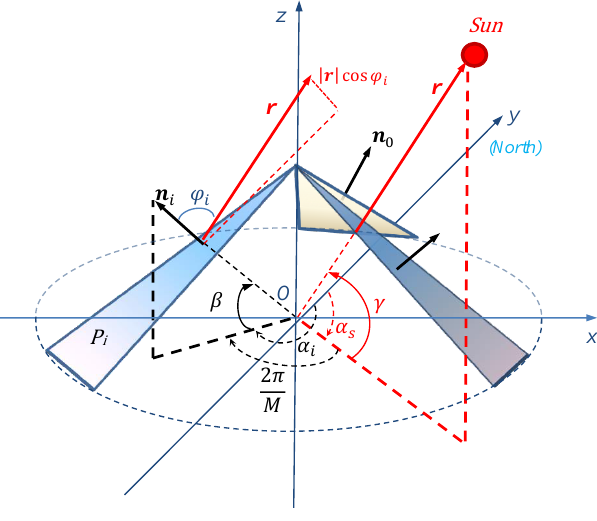
Figure 2. Geometric relationship of the sun vector and the regular pyramid sensor array in an x-y-z Cartesian coordinate system: the sun vector r has an azimuth angle 𝛼 𝑠 and elevation angle 𝛾 ; the sensor plane P i is mounted on the lateral side of the regular pyramid at azimuth angle 𝛼 𝑖 and elevation